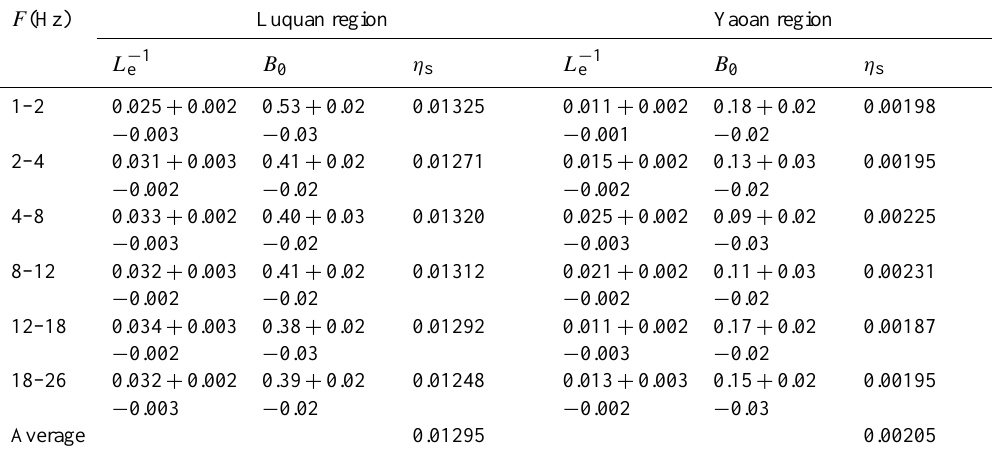
Table 3. Calculated results of seismic albedo B 0 , inverse of extinction length L − 1 e and scattering coefficients η s in the Luquan and Yaoan